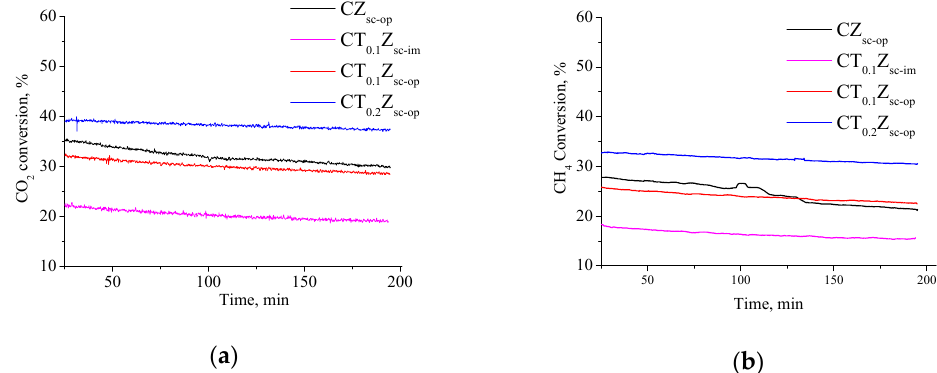
Figure 16. The dependence CO 2 ( a ) and CH 4 ( b ) on reaction time at 700 ◦ C for the one-pot and impregnated SCS catalysts.